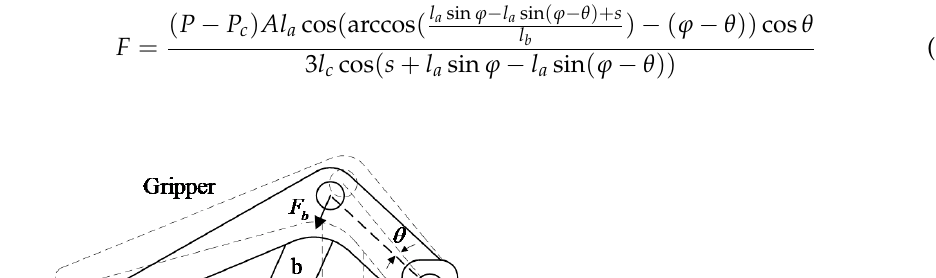
where P c is the contact pressure of the soft actuator and A is the bottom area of the cylindrical cavity of the soft actuator, which is consistent during processing. By substituting Equations (4) and (5) into Equation (3), the relationship between the analytical gripping force F and the pressure P , the contact pressure P c is expressed as Equation (6):